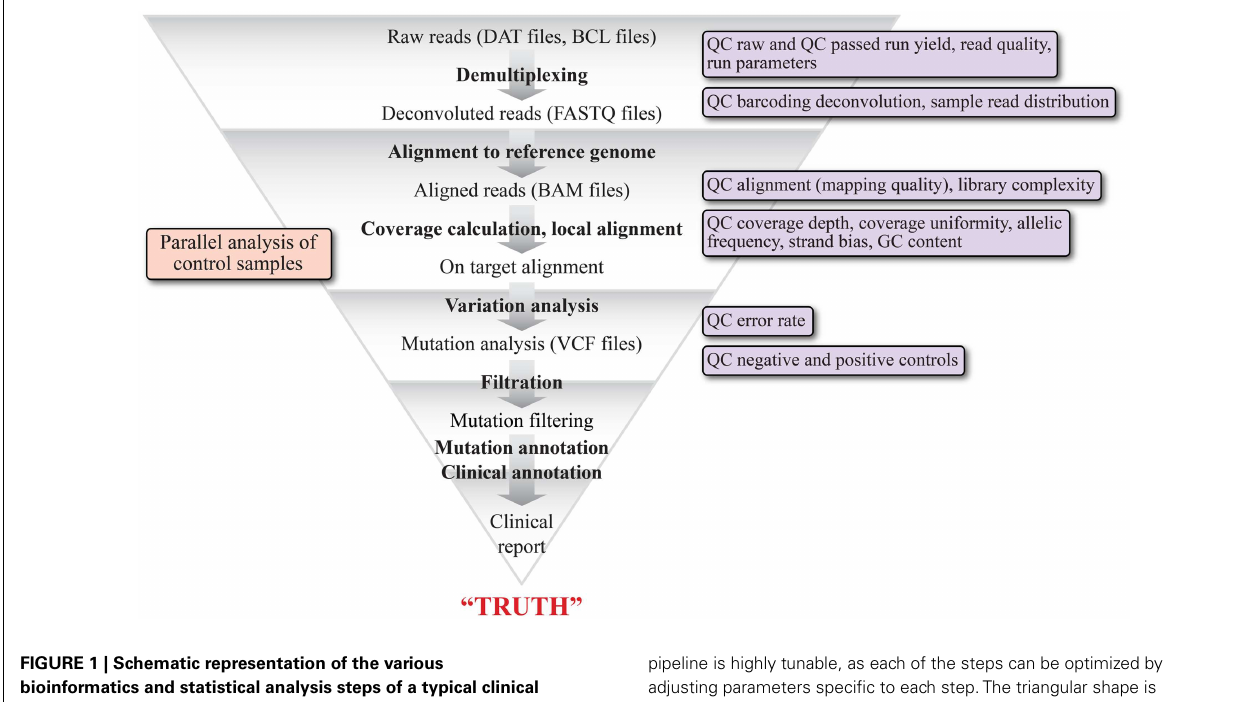
FIGURE 1 | Schematic representation of the various bioinformatics and statistical analysis steps of a typical clinical NGS variant detection data pipeline .The graphic illustrates the major modules of the pipeline and their output file types, beginning with raw reads (DAT files) and ending with a clinical report.The